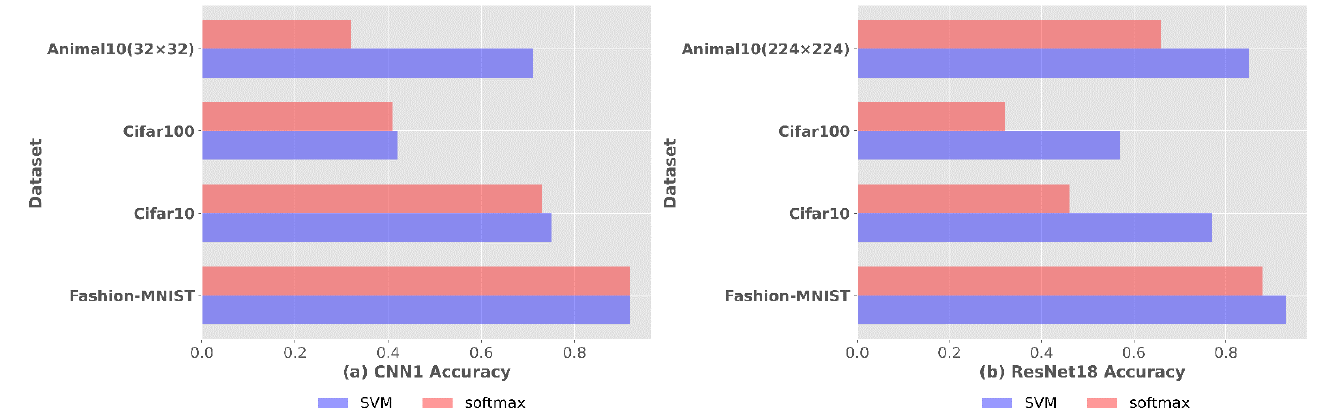
Figure 4. Classification accuracy of two network models on four datasets.